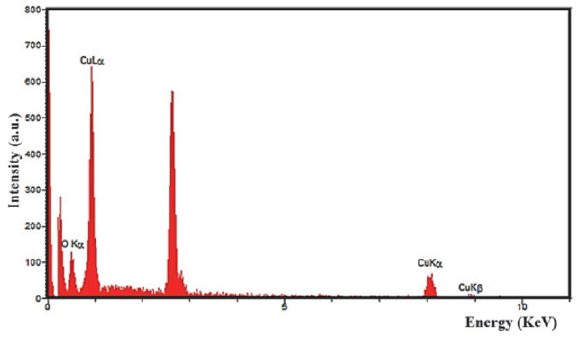
Figure 6 . EDX spectra of calcinated CuO nanofibers.